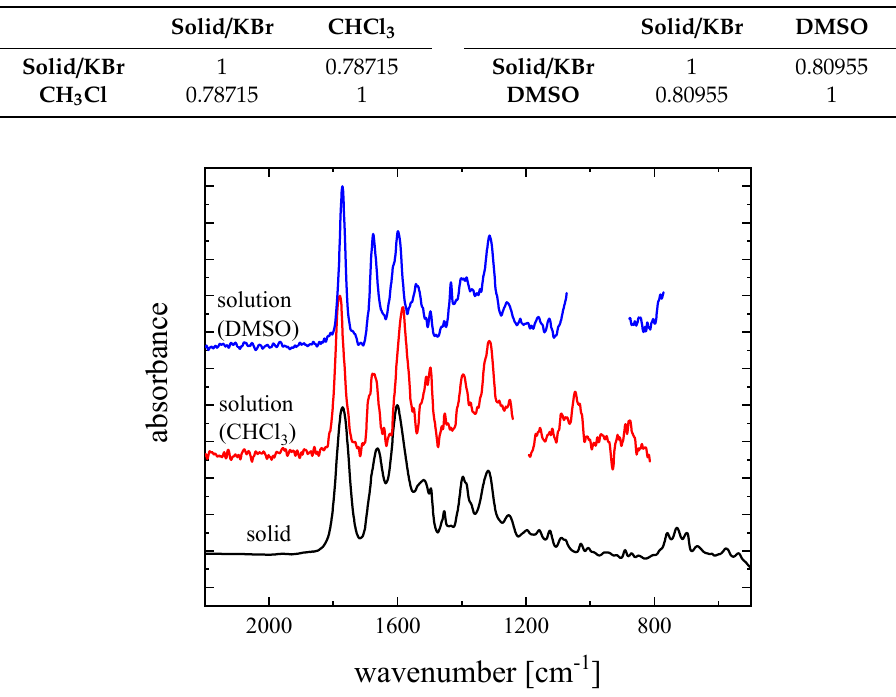
Figure 3. ATR-FTIR spectra of solutions with DMSO and CHCl 3 as solvents and of the solid phase. The spectra exhibit characteristic similarities in both liquid and solid phases.